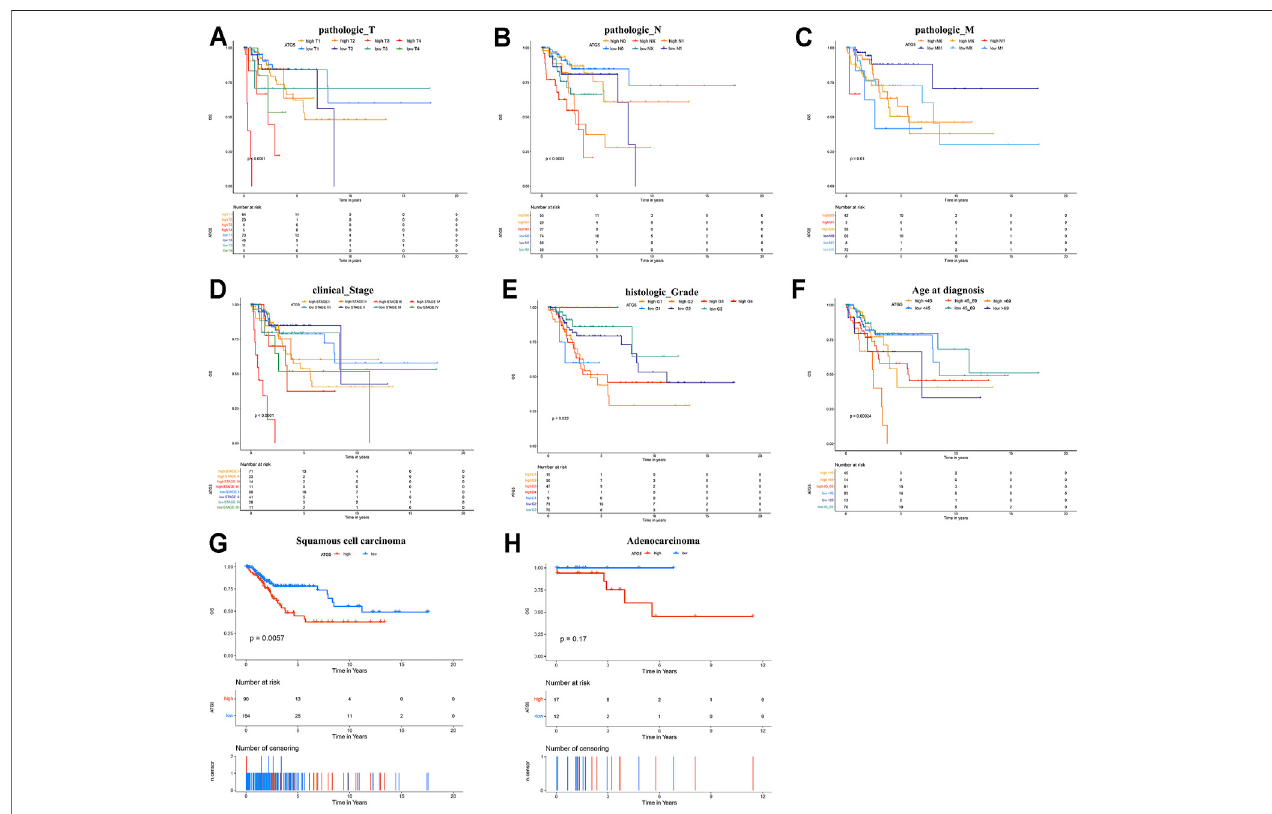
FIGURE 2 | Kaplan-Meier survival analysis of ATG5 compared with different clinical parameters. By comparison, high expression of ATG5 in cervical patients with most different (A) T stage (B) N stage (C) M stage (D) FIGO stage (E) pathological grade, and (F) Ages at diagnosis showed shorter median OS time; Cervical patients with (G) Cervical squamous cell carcinoma, and (H) Cervical adenocarcinoma had shorter OS in ATG5 overexpression group.